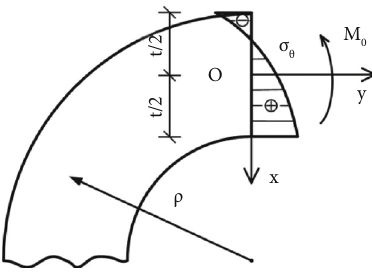
Figure 5: The angle θ 0 corresponds to the circumferential stress distribution at the radial